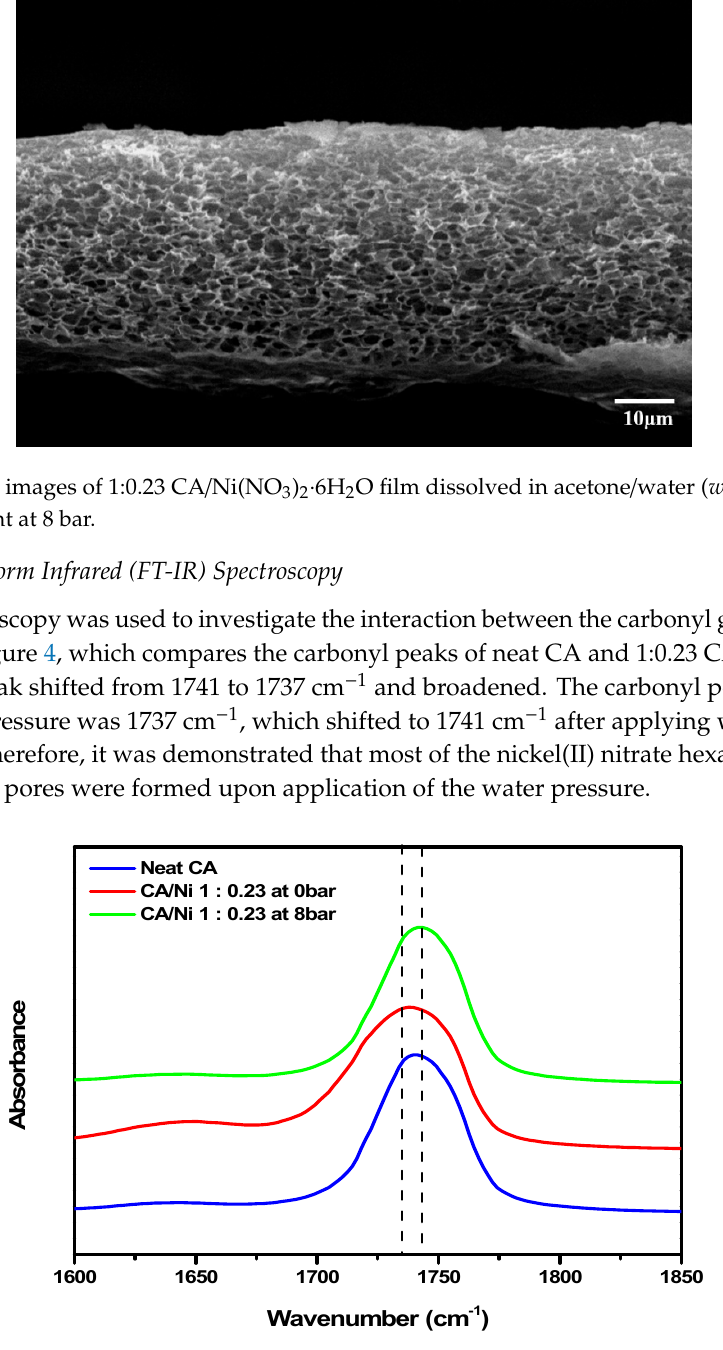
Figure 4. FT-IR spectra of neat CA, 1:0.23 CA / Ni salt at 0 bar and 1:0.23 CA / Ni salt at 8 bar.